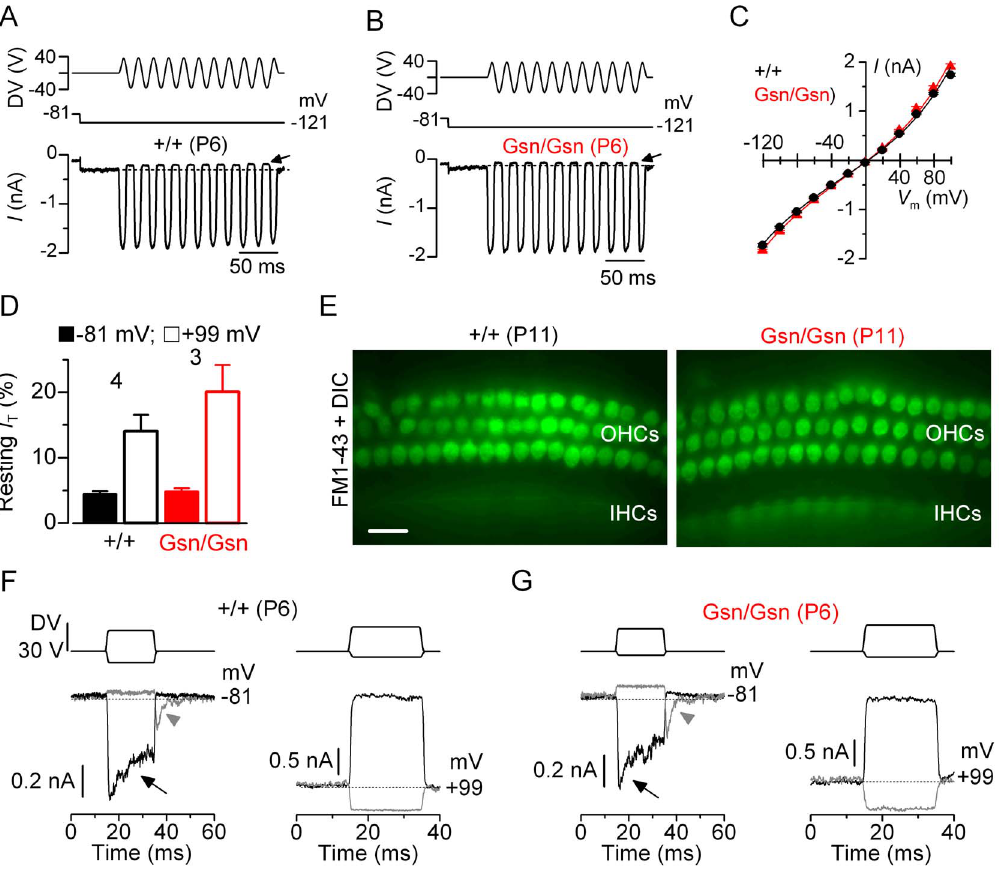
Figure 1. Mechanotransducer currents in outer hair cells from gelsolin knockout mice ( Gsn tm1Djk /Gsn tm1Djk ). A and B , Saturating mechanotransducer (MET) currents recorded from a control ( A ) and a gelsolin knockout ( B ) P6 apical-coil OHC. MET currents (bottom panels) were elicited by applying sinusoidal force stimuli to the hair bundles while changing the membrane potential between 2 121 mV and + 99 mV in 20 mV nominal increments from the holding potential of 2 81 mV (middle panel). For clarity only responses at 2 121 mV are shown. The driver voltage (DV) signal of 6 40 V at 50 Hz to the fluid jet is shown above the traces (negative deflections of the DV are inhibitory). The arrows indicate the closure of the transducer channels, i.e. disappearance of the resting current, during inhibitory bundle displacements. Dashed lines indicate the holding or resting current. C , Peak-to-peak current-voltage curves were obtained from four control and three knockout OHCs (P6) using 1.3 mM extracellular Ca 2 + . The fits through the data are according to eqn.1 (see Methods) with values: control k =494 6 51, V r =2.3 6 0.4 mV, V s =40 6 3 mV, and c =0.41 6 0.01; gelsolin knockout k =537 6 40, V r =1.6 6 0.3 mV, V s =40 6 2 mV, and c =0.42 6 0.01. D , Changes in the resting transducer current at 2 81 mV and + 99 mV in control and knockout OHCs. The resting current is given by the holding current minus the current present during inhibitory bundle deflection. E , Fluorescence images with the DIC image superimposed from the control and knockout P11 cochleae taken after exposure to FM1-43 (both OHCs and IHCs were labelled by the dye). Scale bars: 20 m m. F and G , Driver voltages to the fluid jet (top) and transducer currents recorded at –81 mV (left panels) and + 99 mV (right) from a control and a knockout gelsolin OHC respectively. At –81 mV, positive driver voltages (excitatory direction) elicited inward transducer currents that declined or adapted over time in control and knockout OHCs (arrows). A small transducer current was present at rest (dashed line) and inhibitory bundle displacements turned this off. Upon termination of the inhibitory stimulus, the transducer current in control and knockout OHCs showed evidence of rebound adaptation (arrowheads). These manifestations of MET current adaptation were absent at positive membrane potentials (e.g. + 99 mV) and the resting current increased. homozygous mice [ 12 ] were seen in the double heterozygous mutant mice.